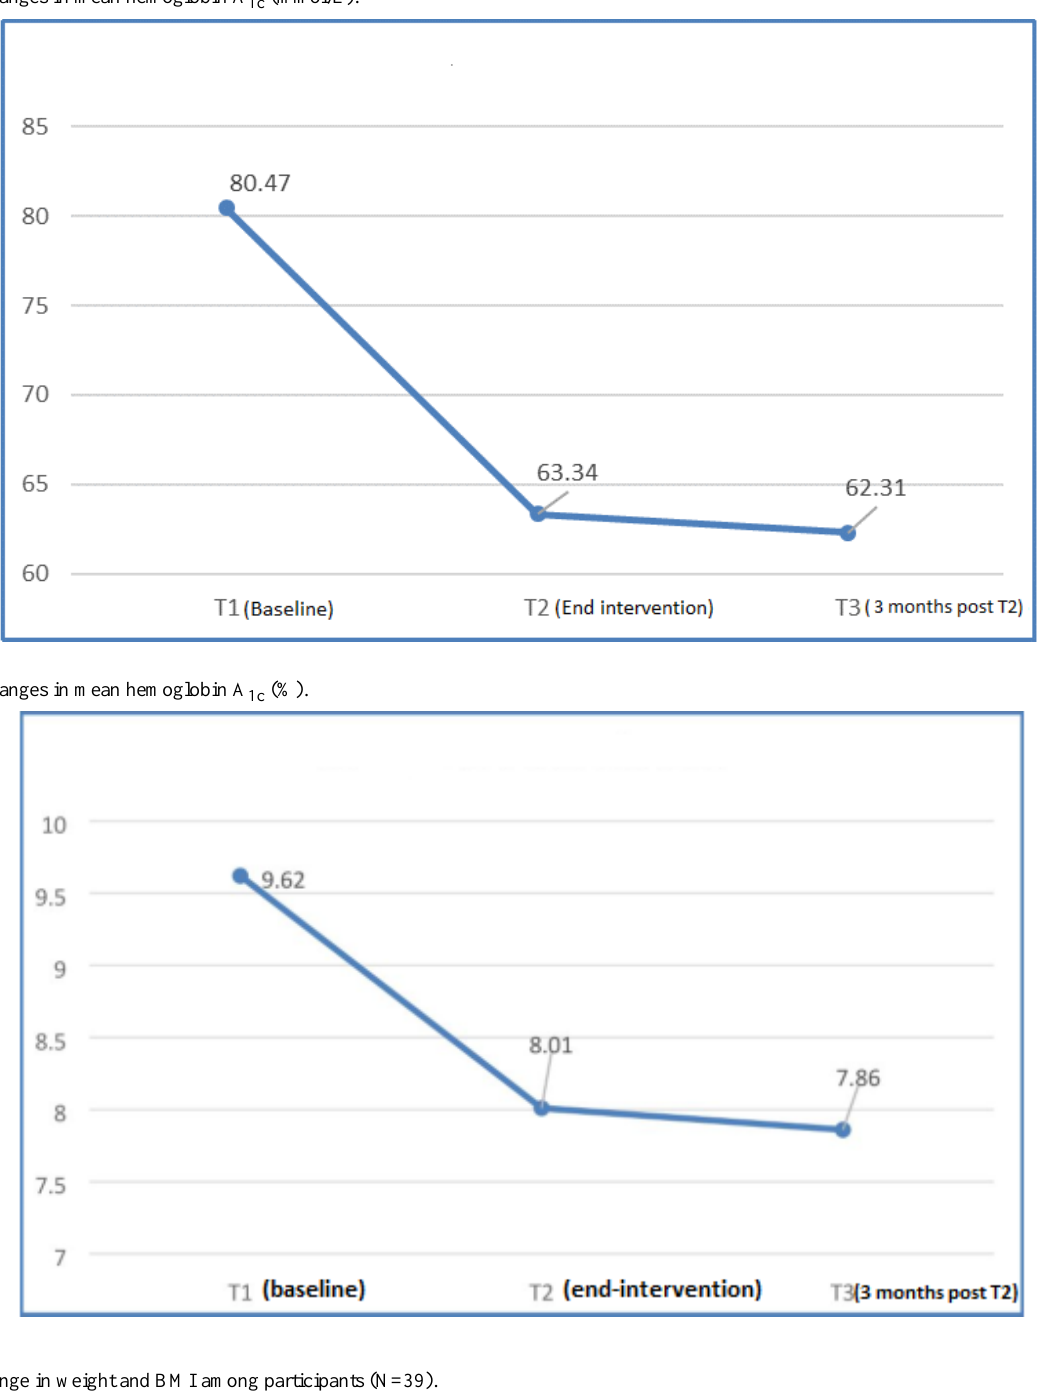
From T1 to T2, an increase in mean DES score (MD 0.62; P< .001) and a decrease in mean DDS score (MD −0.64; P =.002)